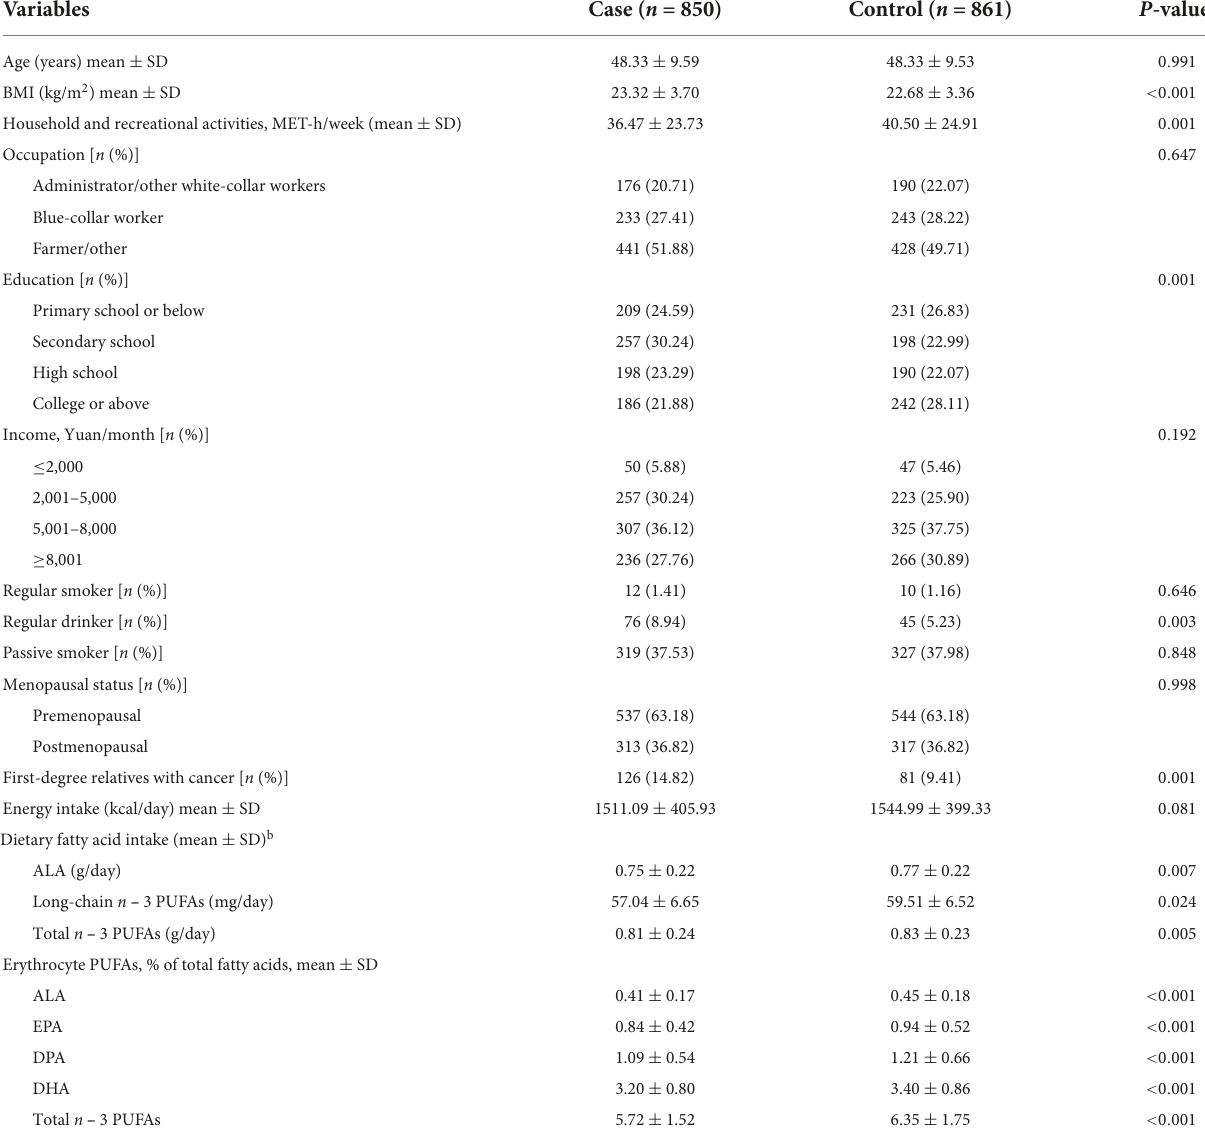
TABLE 1 General characteristics of the study subjects a